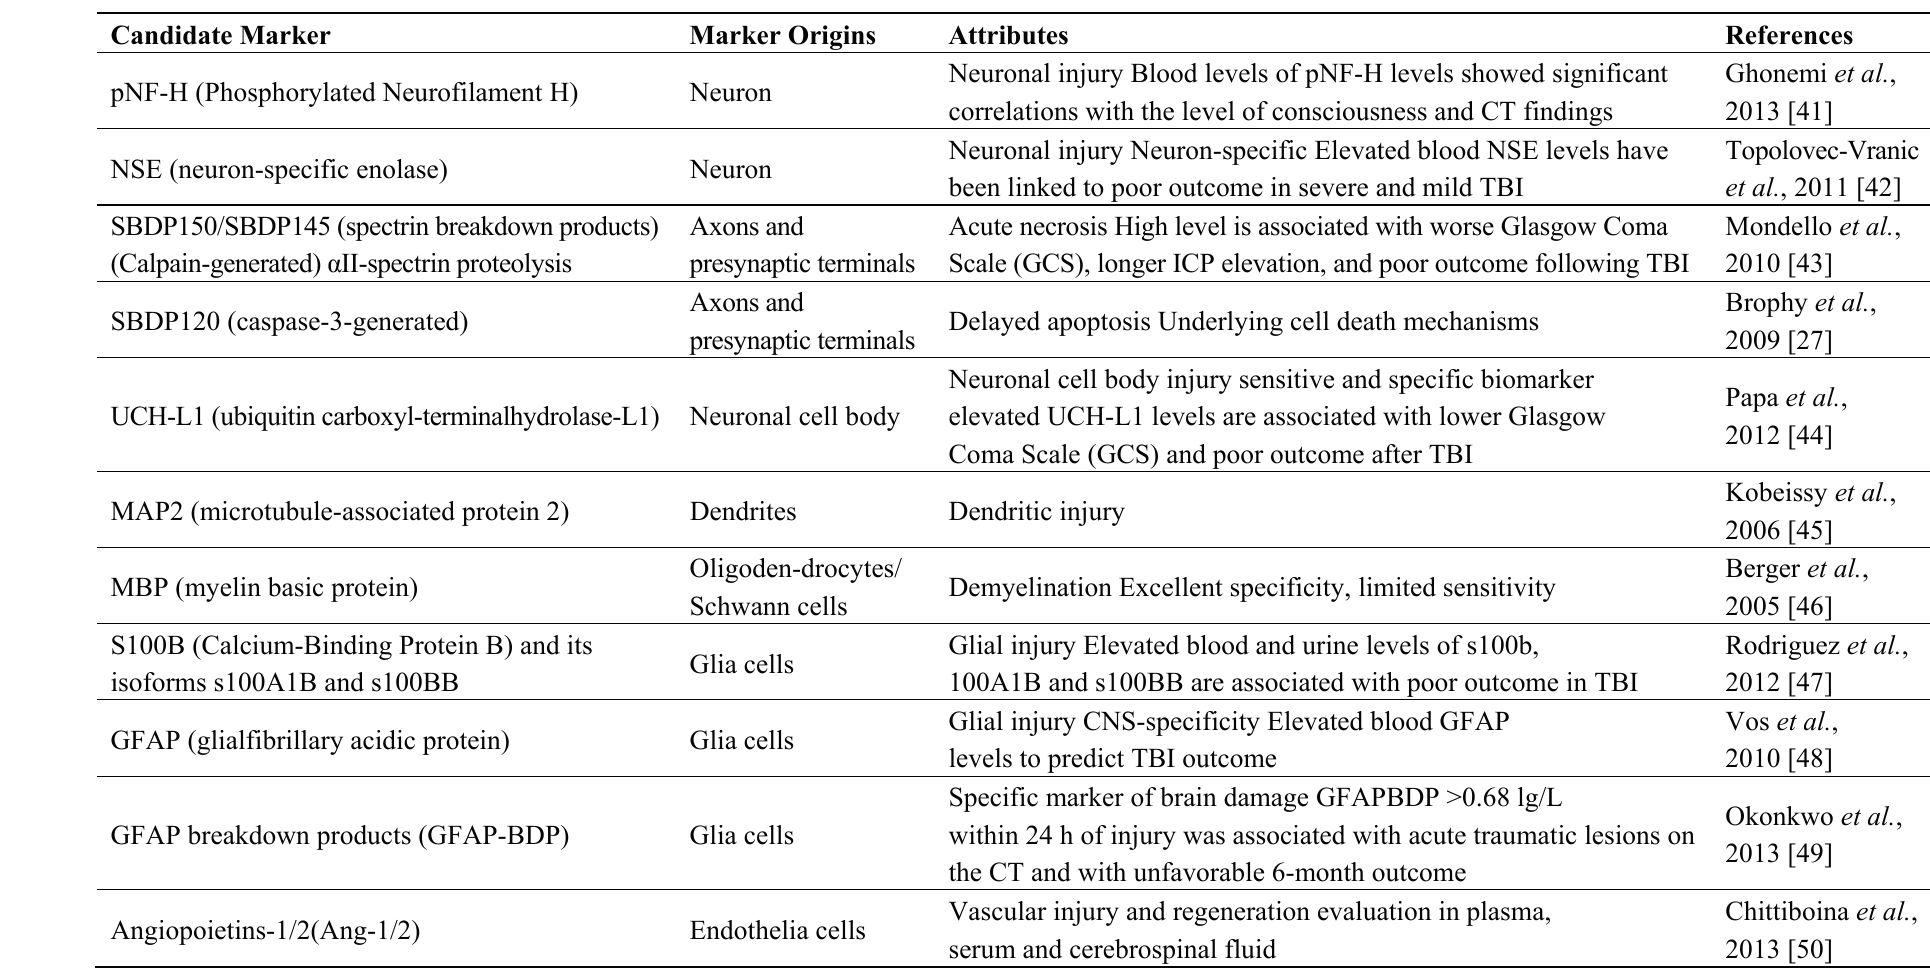
Table 2. Potential molecular biomarkers in